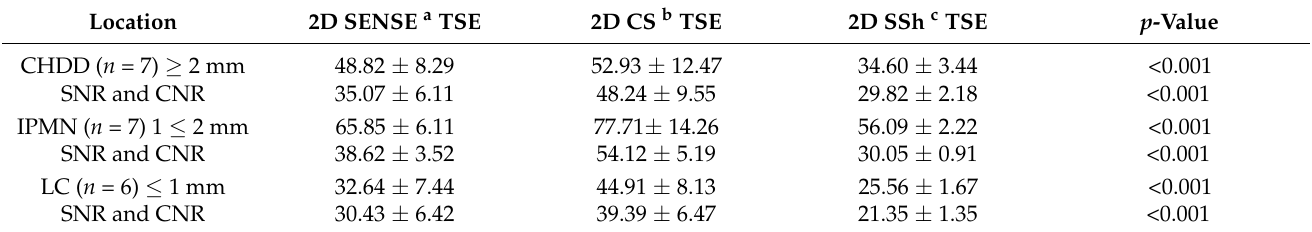
Table 3. SNRs and CNRs values in Patient’s MRCP Images ( n = 20).